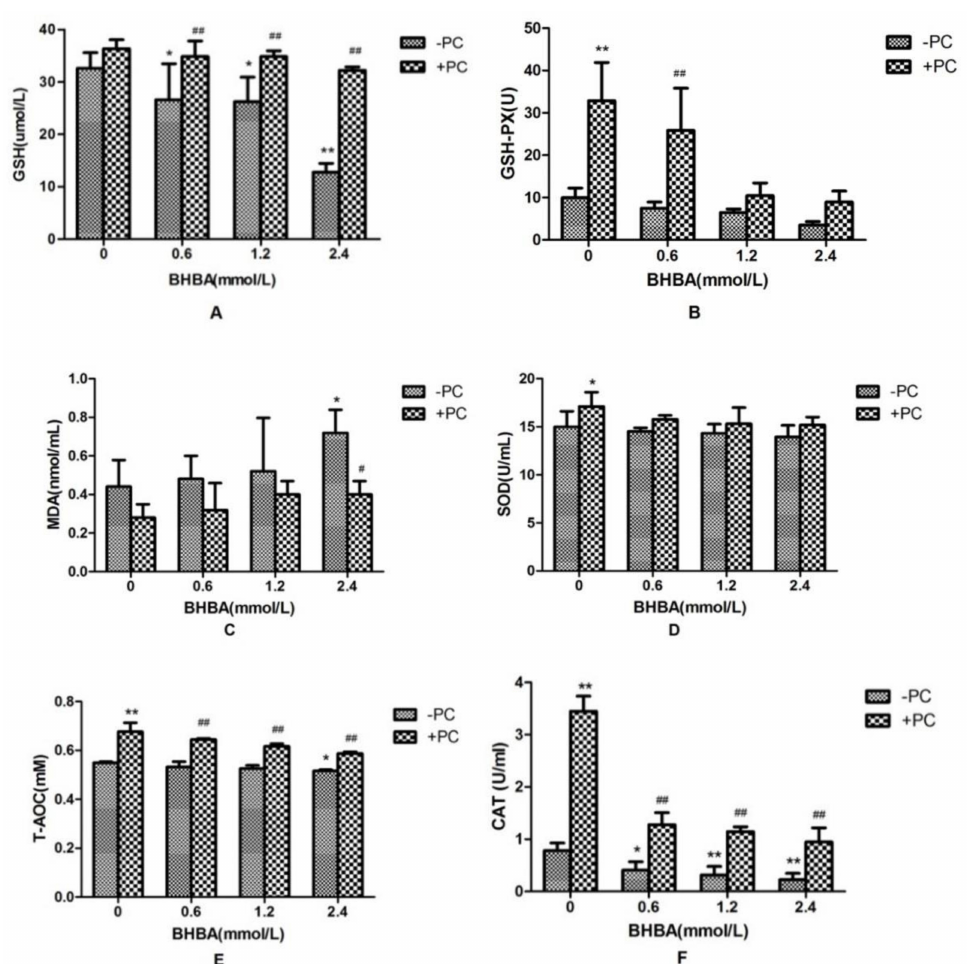
Figure 5. Effects of BHBA and PCs on the antioxidation markers in BEND cells. ( A ) The GSH content. ( B ) The GSH-PX activity. ( C ) The MDA content. ( D ) The SOD activity. ( E ) The T-AOC. ( F ) The CAT activity. * p < 0.05 vs. control group, ** p < 0.01 vs. control group. # p < 0.05 vs. BHBA-treated group, ## p < 0.01 vs. BHBA-treated